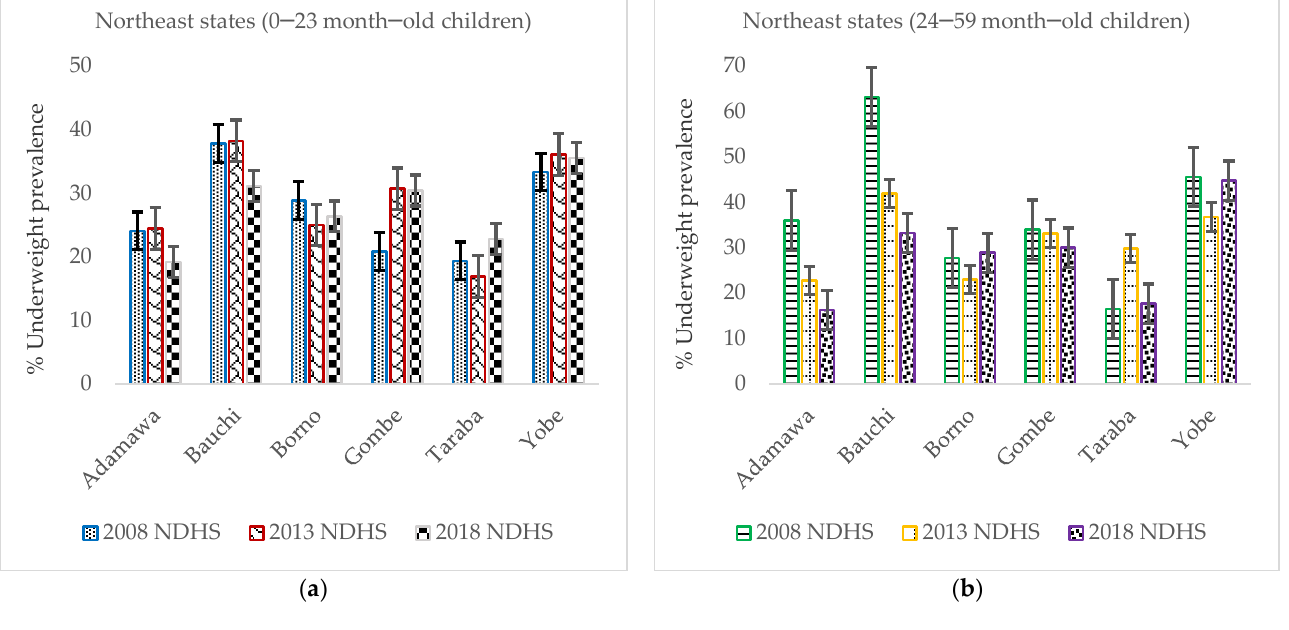
Figure 3. ( a ) Trends in prevalence of underweight among 0–23-month-old children from 2008 to 2018 Nigeria Demographic and Health Survey (NDHS), with a 95% confidence interval (CI) by northeast